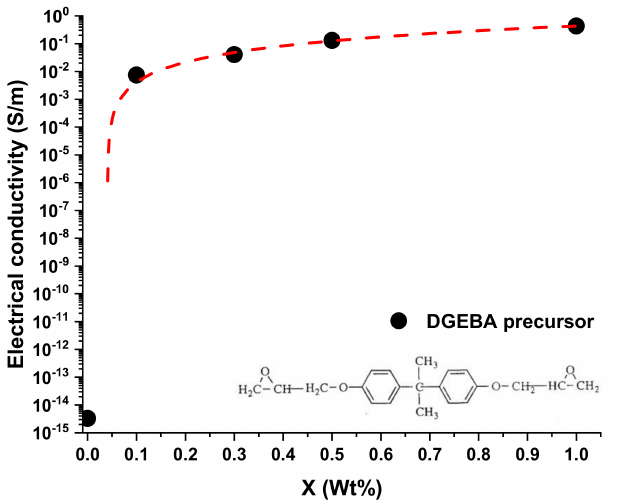
Figure 4. DC volume electrical conductivity (s) of the DGEBA-based formulation versus MWCNT weight percentage.